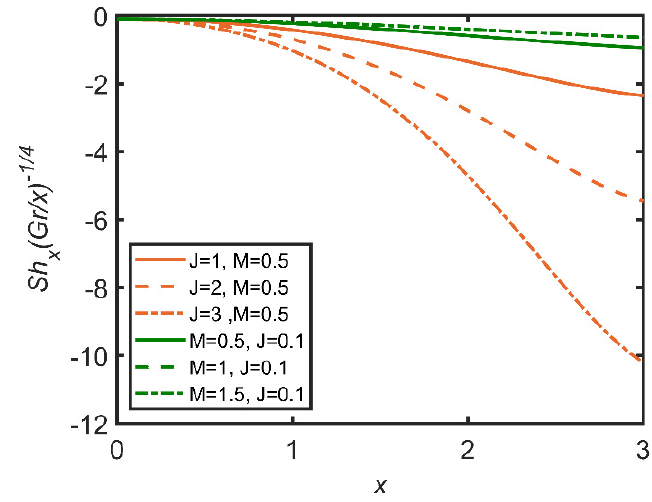
Figure 23. Comparison for Sherwood number against x.